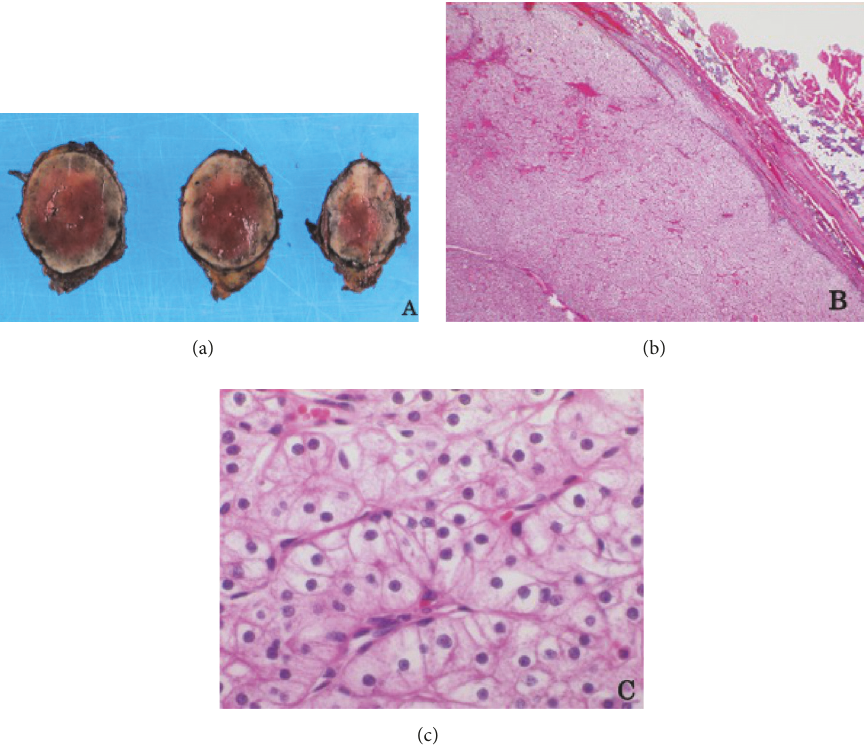
Figure 2: Histopathologic findings of parotid clear cell oncocytoma. (a) A well-circumscribed, solid, mahogany-colored nodule. (b, c) Microscopically, fibrous encapsulated nodules containing oncocytic tumor cells with a clear cytoplasm. (hematoxylin-eosinstaining; original magnification, 20 × in (b) and 400 × in (c))